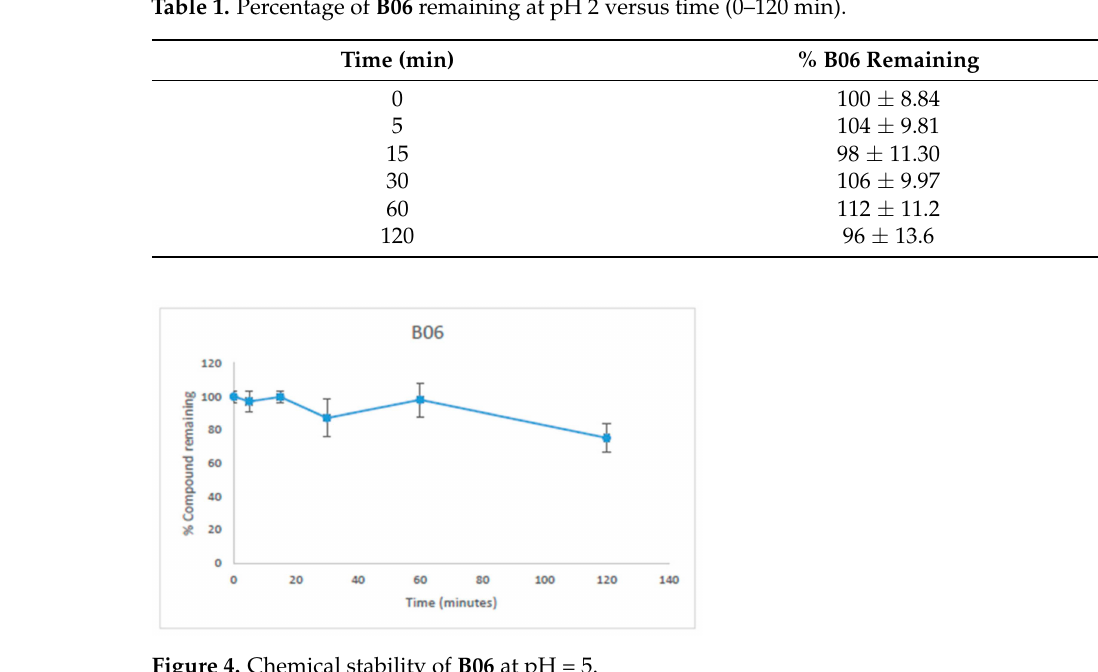
Figure 4. Chemical stability of B06 at pH = 5. Table 2. Percentage of B06 remaining at pH 5 versus time (0–120